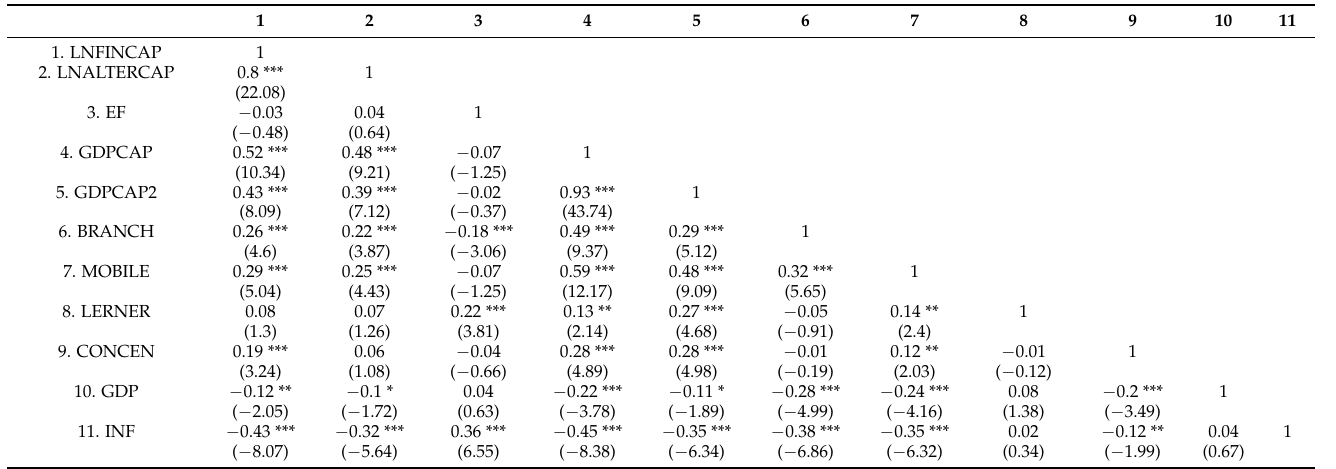
Table A4. Correlation matrix between variables used in this